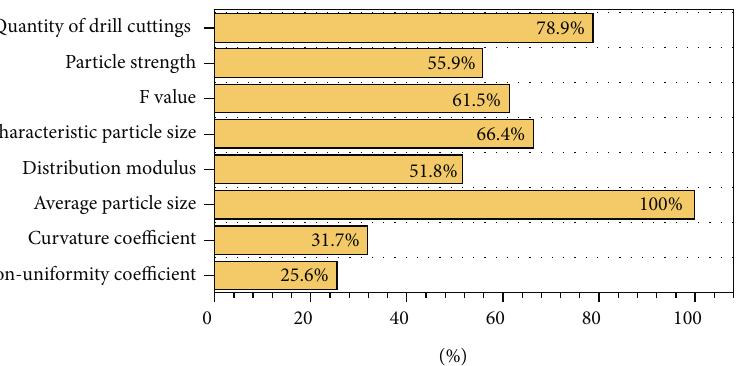
Figure 12: Variable weight analysis